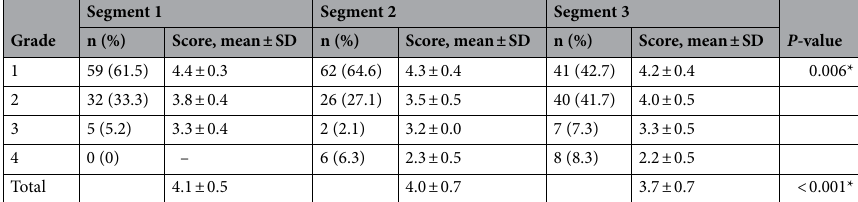
Table 2. Clinical grading and cleansing scores of each small bowel segment in the validation set (n = 96). SD, standard deviation. * P -values for grade distribution and average cleansing scores per segment,